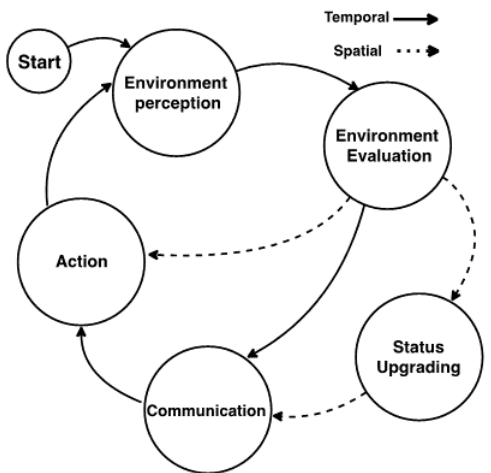
Figure 3. A finite state machine (FSM) representation corresponding to state transition of the agent’s behavior.